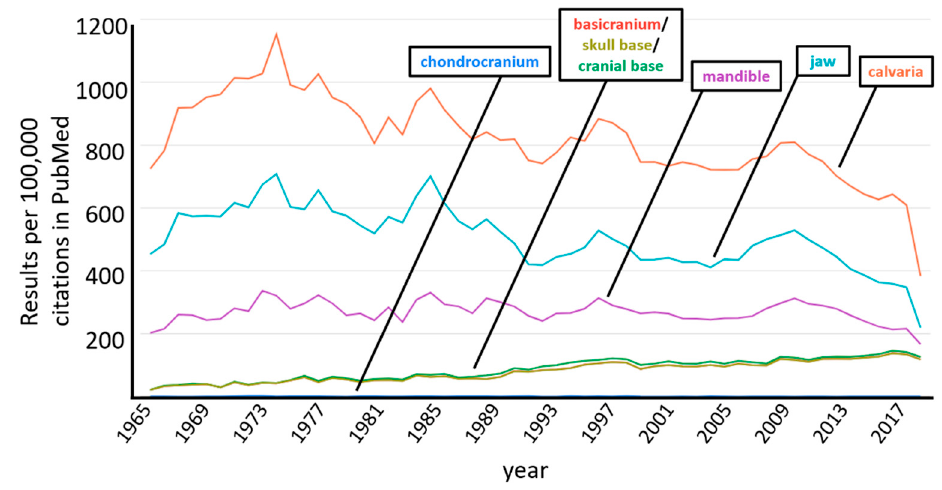
Figure 1. Graph depicting a keyword search of the PubMed database showing the number of articles (results per 100,000) containing the searched term (results from 1965 to 2019 shown). Note, ‘basicranium’, ‘skull base’ and ‘cranial base’ all track together, while ‘chondrocranium’ is indistinguishable from baseline of the X-axis. (Generated using, PubMed by Year: http://esperr.github.io/pubmed-by-year).